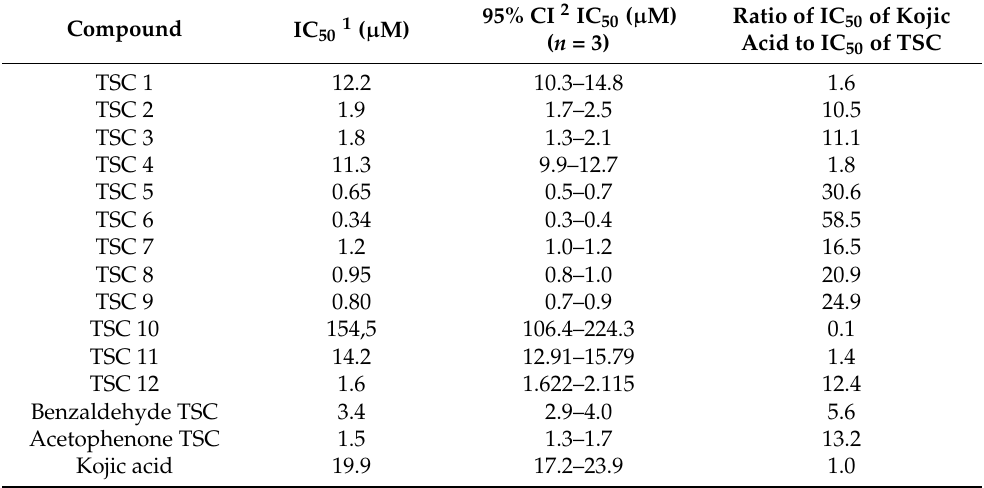
1 Inhibitor concentration required for 50% inhibition; 2 confidence